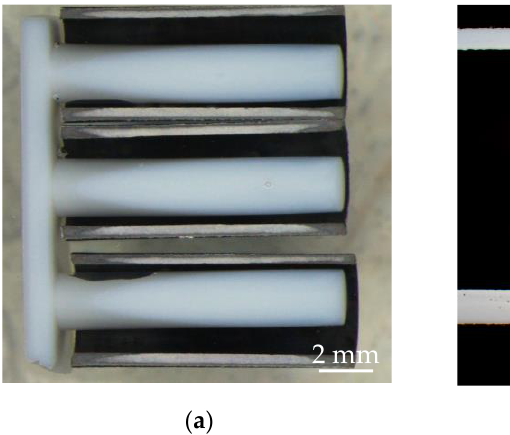
Table 1. Nitriding process parameters for all sample iterations on H11 tool steel.